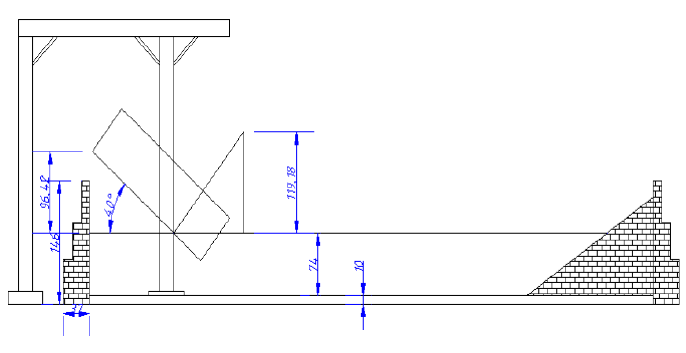
Figure 4. Layout of the sliding frame.